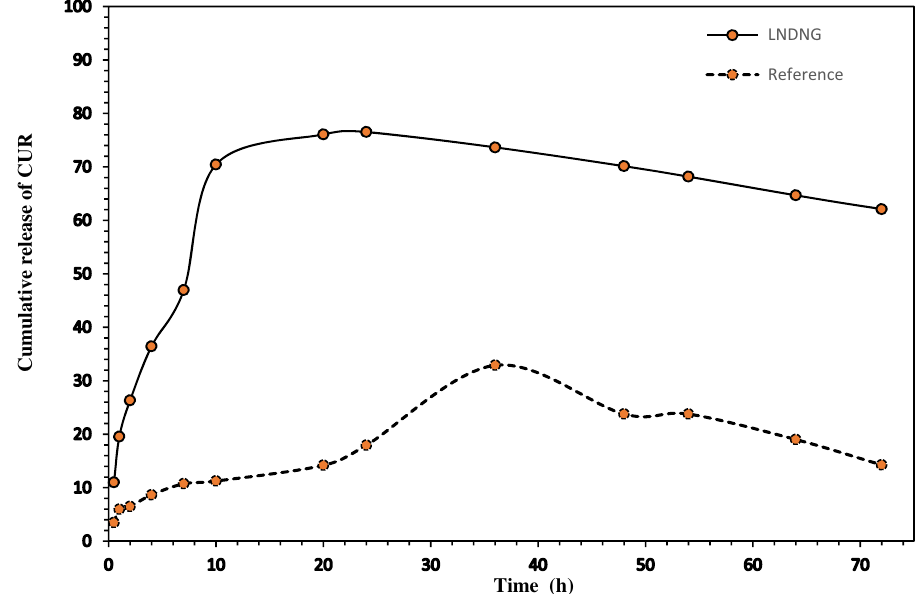
Figure 6. Comparison of CRU release behavioral pattern between LNDNG system and reference sample as a function of